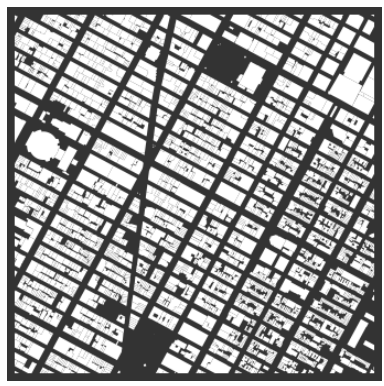
Figure 7: Output from codebox 19